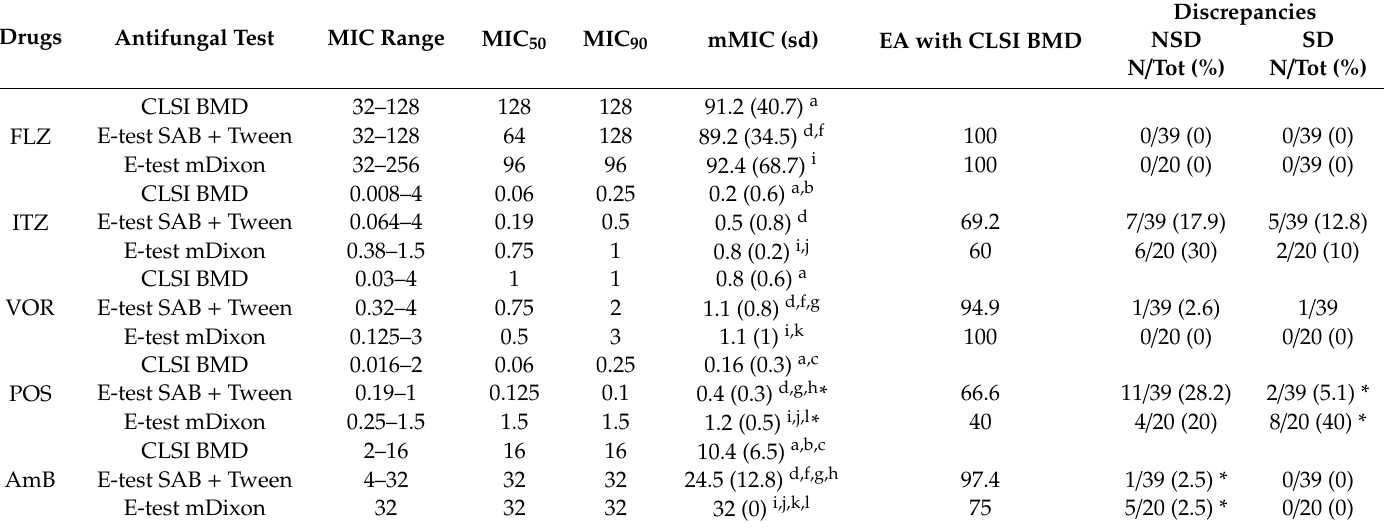
Table 1. Fluconazole (FLZ), itraconazole (ITZ), voriconazole (VOR), posaconazole (POS) and amphotericin B (AmB) minimum inhibitory concentration (MIC; µ g / mL) data after 48 h of incubation obtained with Clinical and Laboratory Standards Institute broth microdilution (CLSI BMD) and E-test in Sabouraud + 1% Tween 80 and in mDixon of Malassezia furfur strains from immunocompromised patients with fungemia. Essential agreement (EA) and discrepancies among MIC obtained by E-tests compared with the CLSI BMD method were also reported.